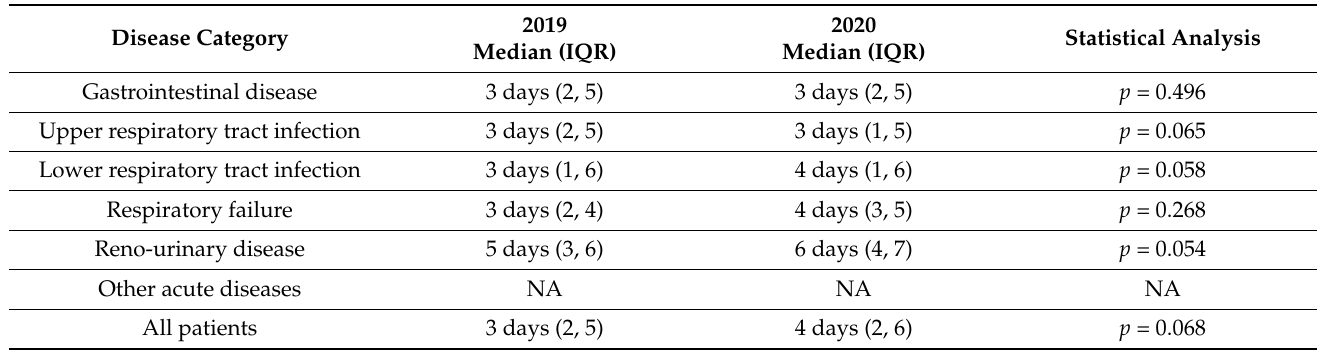
Table 4. Median duration of hospitalization by pathology and period